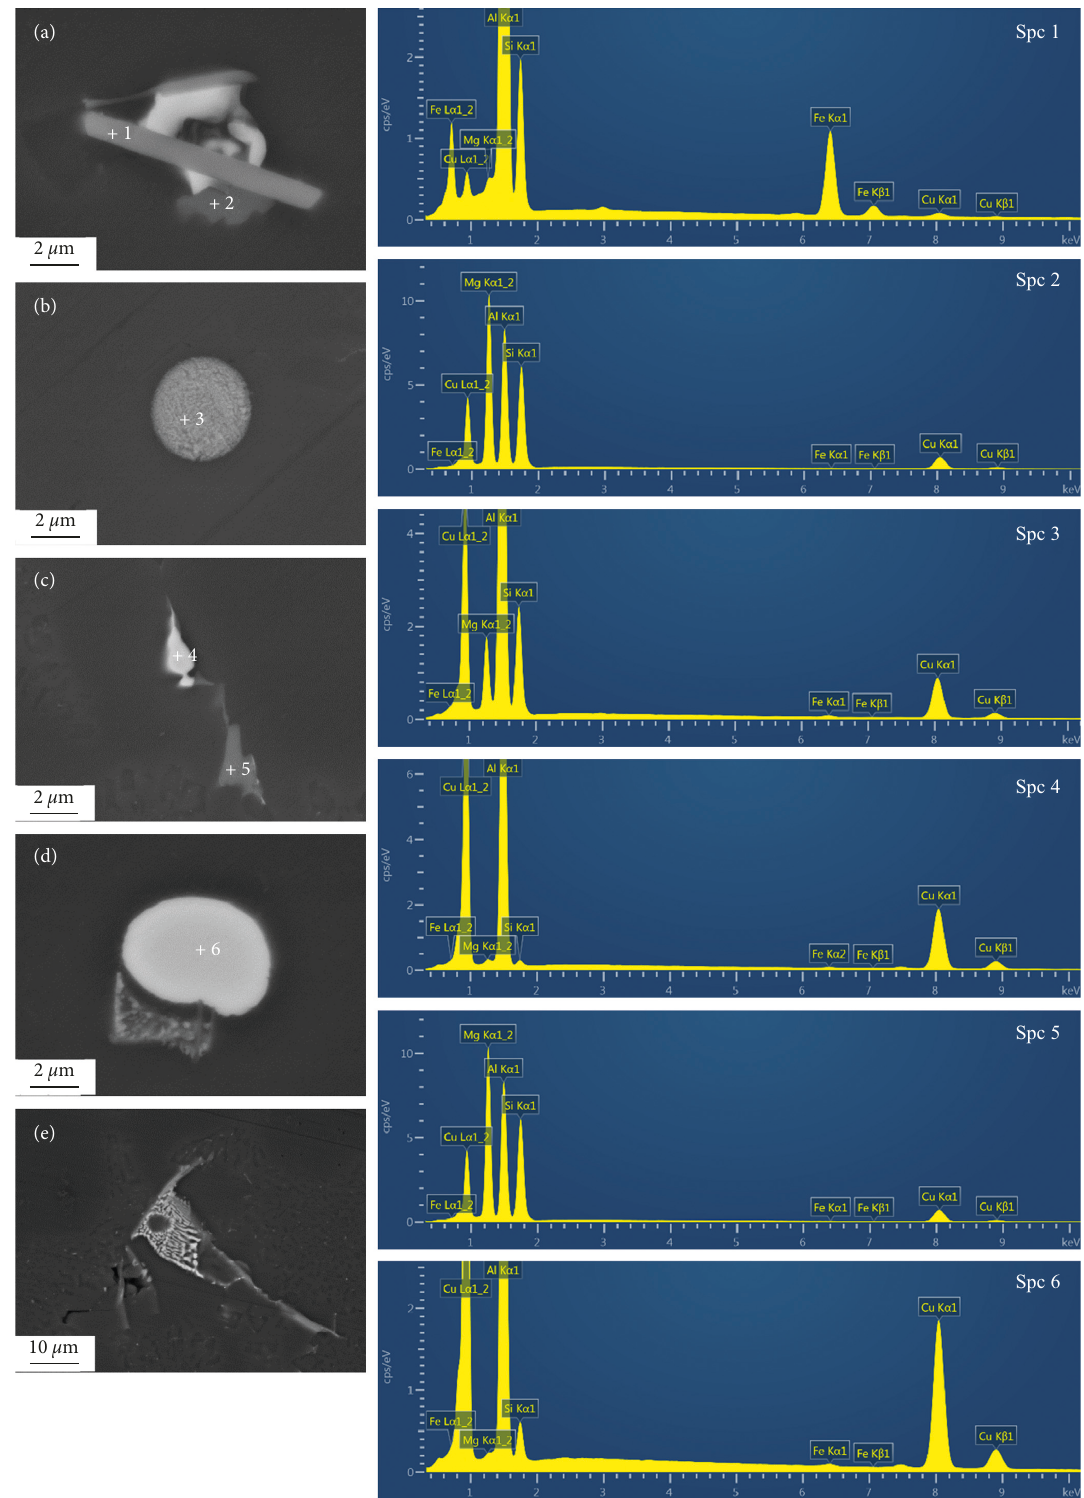
Figure 6: BSE images of some intermetallic phases detected in the Cu-containing alloy (Cu1), in the as-cast condition. EDS measurements indicate the nature of the intermetallic compound as Al 2 Cu, β -Al 5 FeSi, and Cu/Mg bearing